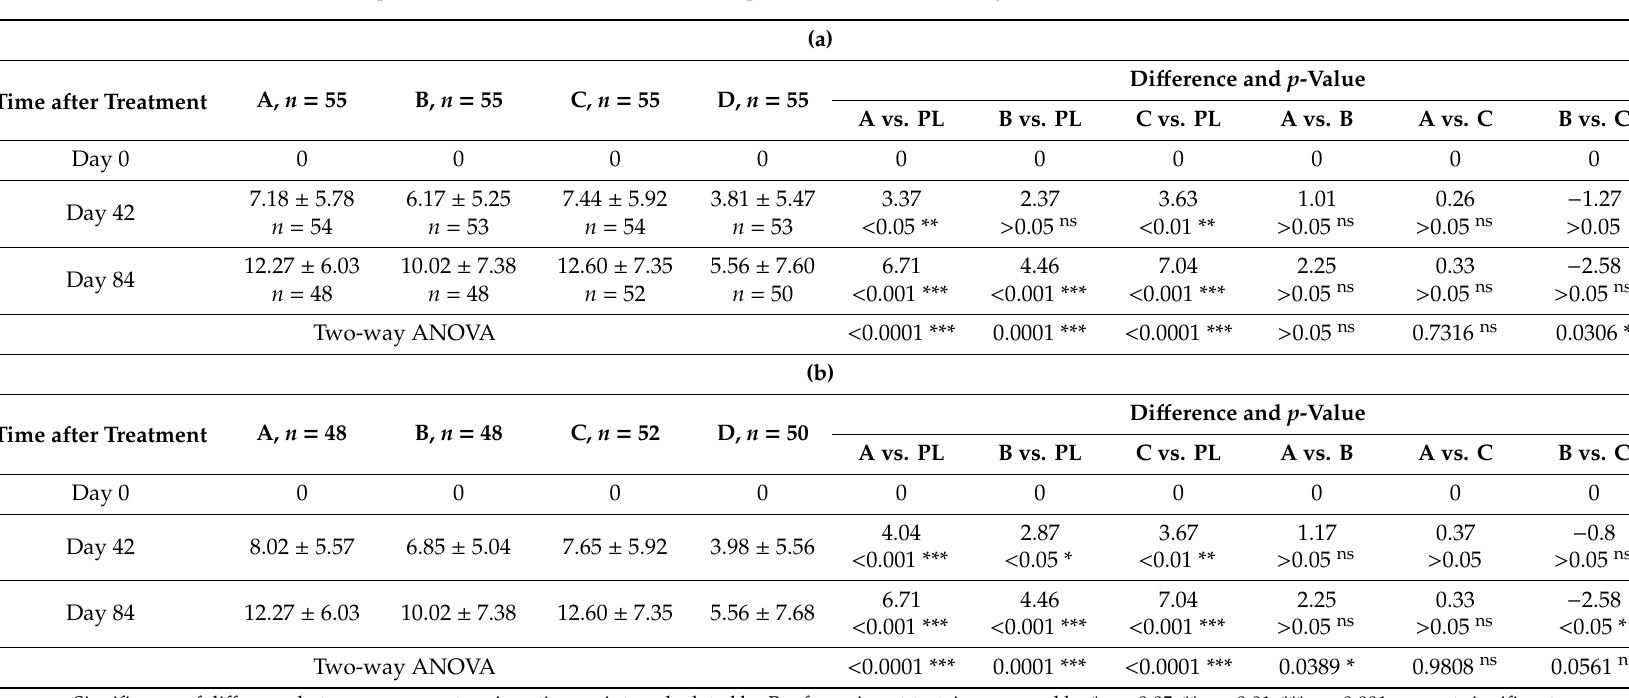
Table A3. ( a ). The change from baseline of MRS (mean ± SD) over time. All patients including dropouts—ITT analysis. ( b ). The change from baseline of MRS (mean ± SD) over time. Patients completed the treatment and all tests, dropouts excluded—PP